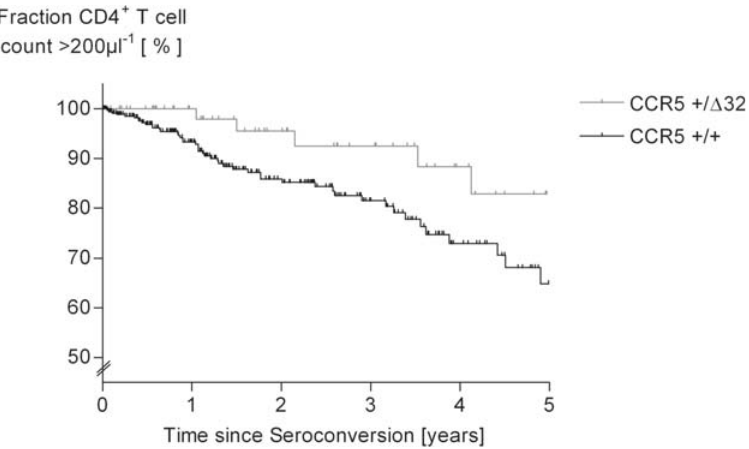
Figure 2. Kaplan Meier Analysis of 506 seroconverters showing a relation of CCR5 D 32 genotype with a CD4 + T-cell count , 200 m l 2 1 . A CD4 + T-cell count , 200 m l-1 was documented for n=57 of 422 individuals homozygous for the wildtype CCR5 genotype, and for n=9 out of 84 CCR5 D 32 heterozygotes. Data censoring was due to introduction of antiretroviral therapy before a CD4 cell count of 200 m l 2 1 was reached. The difference between both groups implied by the Kaplan-Meier diagram is reflected in a statistical trend (p=0.1 as calculated by the Log-Rank test).